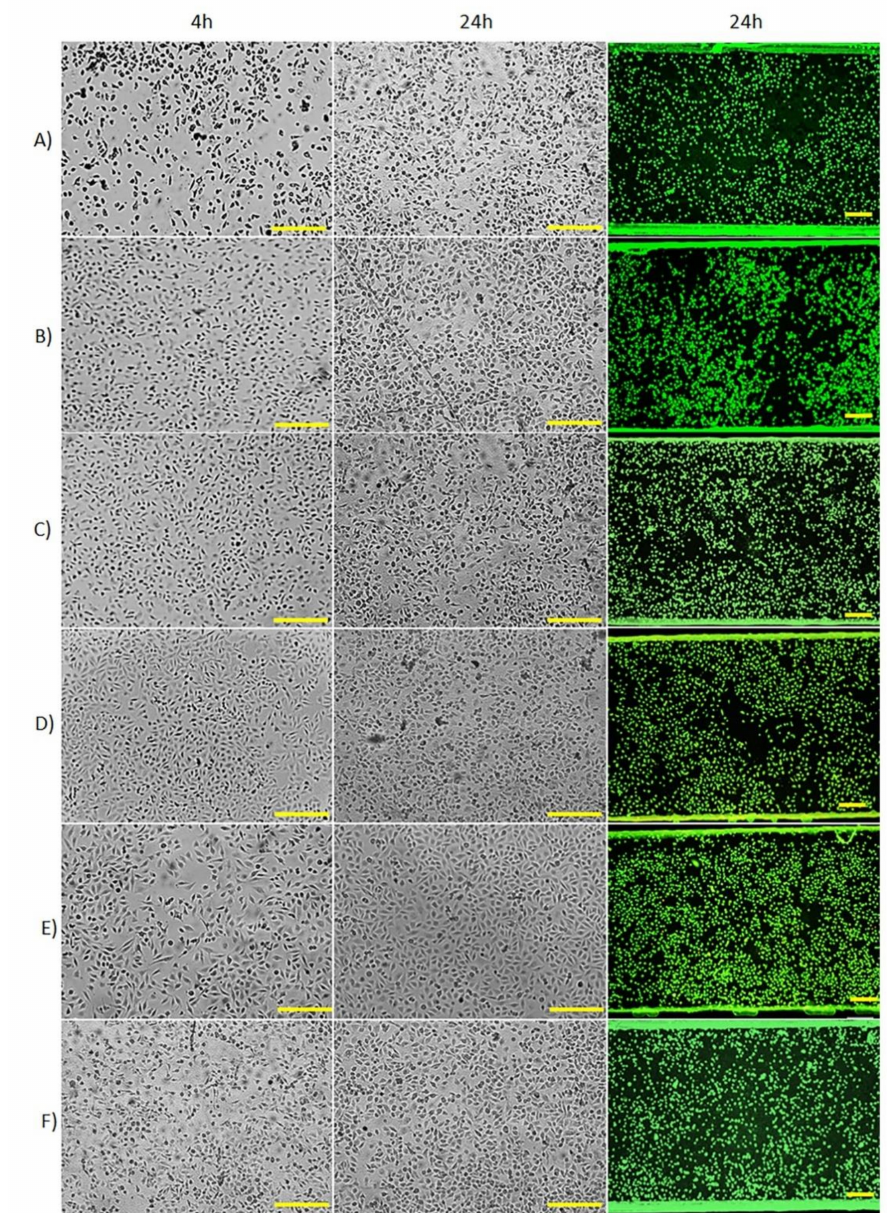
Figure 7. HUVEC (5 × 10 6 cells mL –1 ) proliferation after 4 h and 24 h of incubation at 37 ◦ C with RPMI-1640 culture medium flow rate at 2 µ L min − 1 in the microchannel of biocompatible double-sided adhesive microchips made with top-bottom layers: ( A ) glass slide-glass slide, ( B ) coverslip-glass slide, ( C ) glass slide-Permanox ® , ( D ) polyester-Permanox ® , ( E ) glass-polystyrene slide, ( F ) polyester-polystyrene slide. The cell viability was detected by the mixture of AO and EB staining. Green dots correspond to live cells and red-orange dots correspond to dead cells. Scale bar = 200 µ